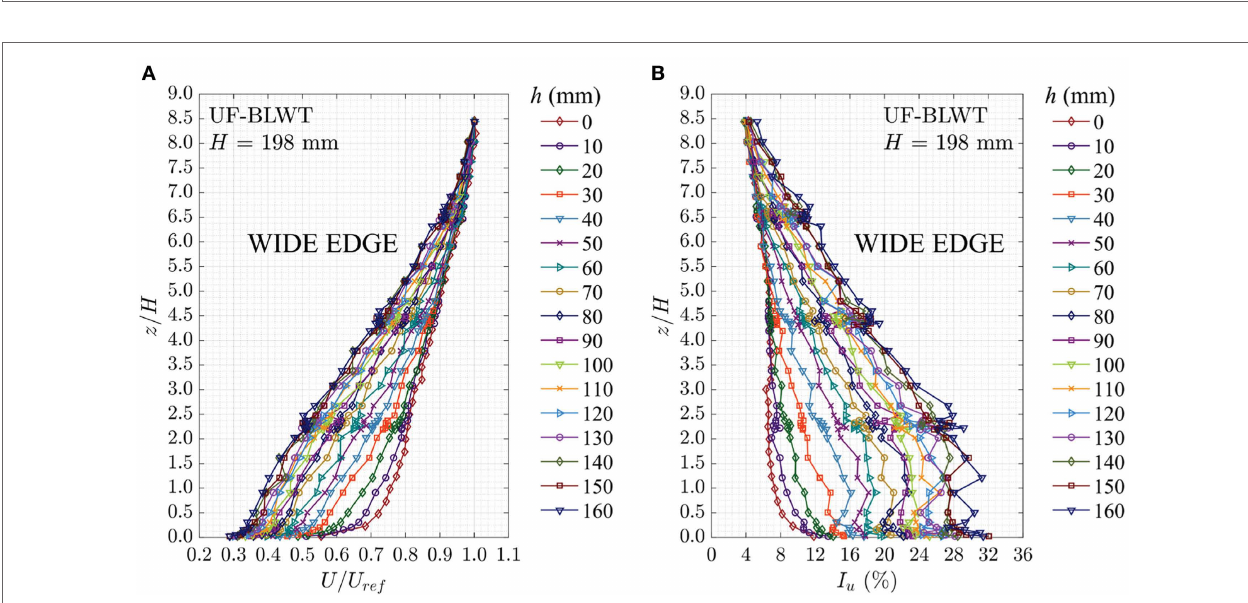
FIGURE 3 | Longitudinal mean velocity (A) and longitudinal turbulence intensity (B) profiles for a wide edge windward element orientation.